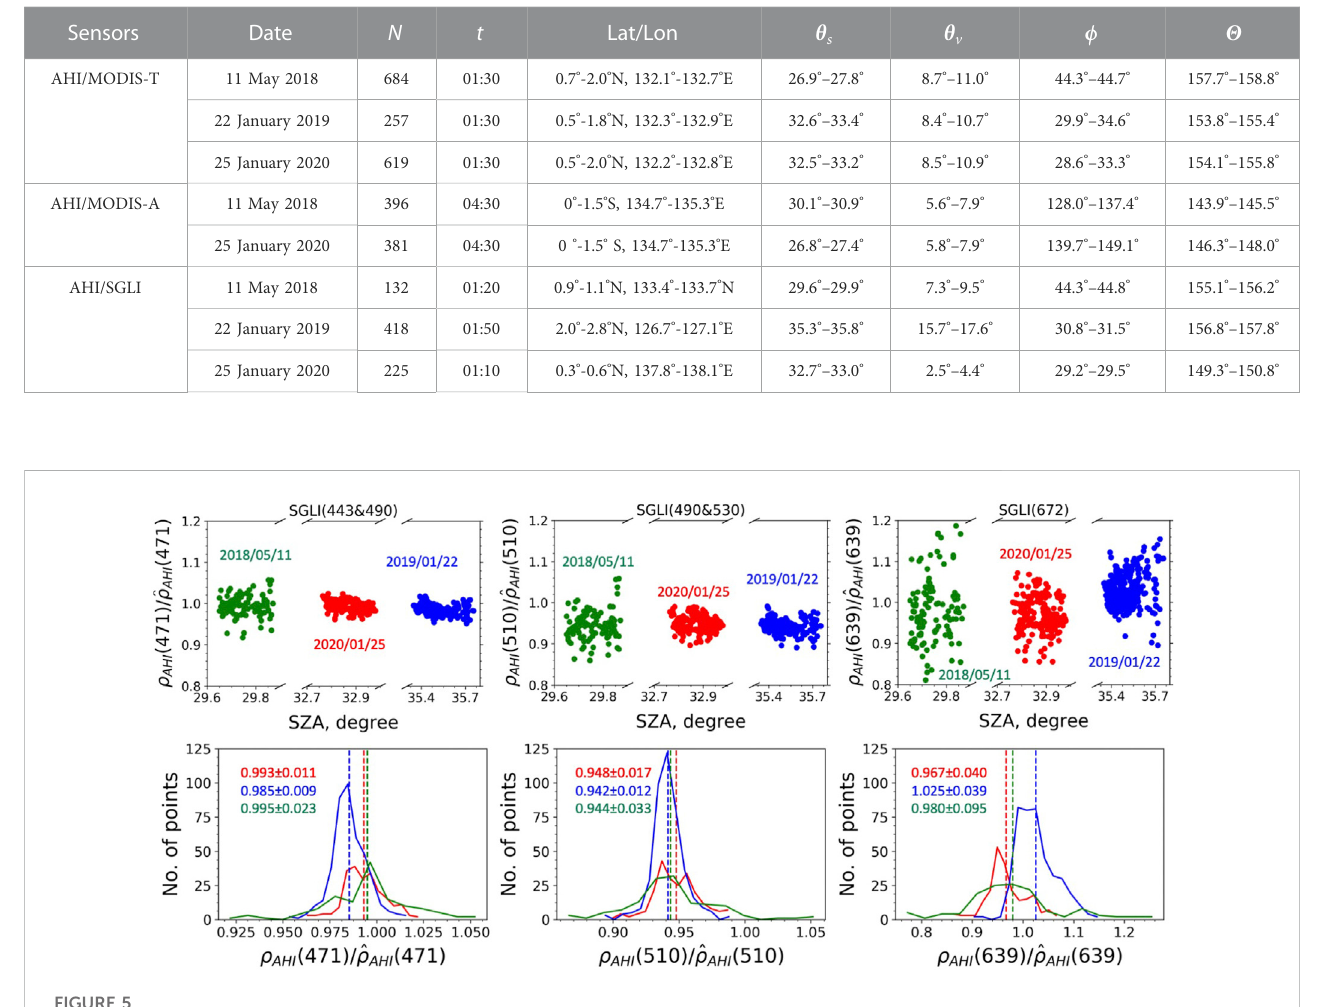
FIGURE 5 (Top)cross-calibrationcoef fi cientsversussolarzenithangle,SZA,and(bottom)histogramsofcross-calibrationcoef fi cientsforAHI/SGLIat471,510,and 639 nm. The equivalent AHI re fl ectance ^ ρ AHI at 471, 510, and 569 nm was generated using SGLI at 443 and 490 nm, 490 and 530 nm, and 672 nm, respectively. Different colors represent different dates. Vertical lines indicate the means, whose values, together with standard deviations, are speci fi ed in the